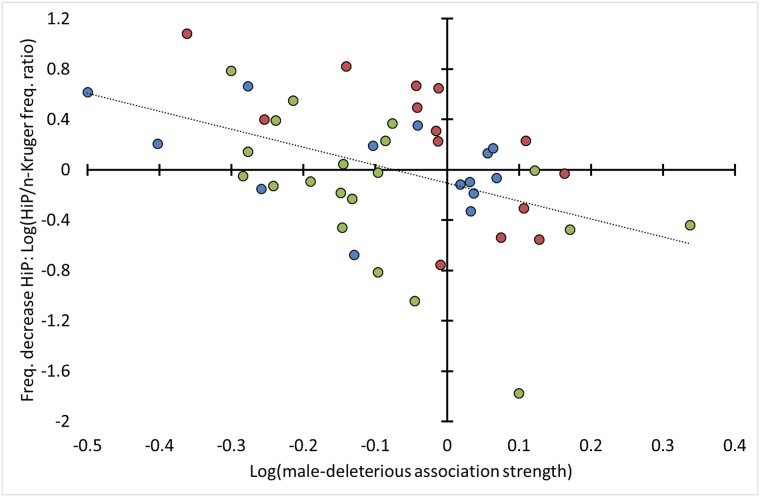
Negative correlations between allele frequency decrease in HiP and male-deleterious association strength.Blue data points: DEindv alleles (ρ = -0.38, P = 0.32, Nalleles = 14; independent variable is Asex-indep), red data points: SAEindvN alleles (ρ = -0.78, P = 0.0030, Nalleles = 14, independent variable is Amale-spec), green data points: SAEindvO alleles (ρ = -0.50, P = 0.023, Nalleles = 20; independent variable is Asex-anta), Nalleles = 48, combined P = 0.00033 (Z-transform test based on the three Spearman correlations). Test 3, Table 2.